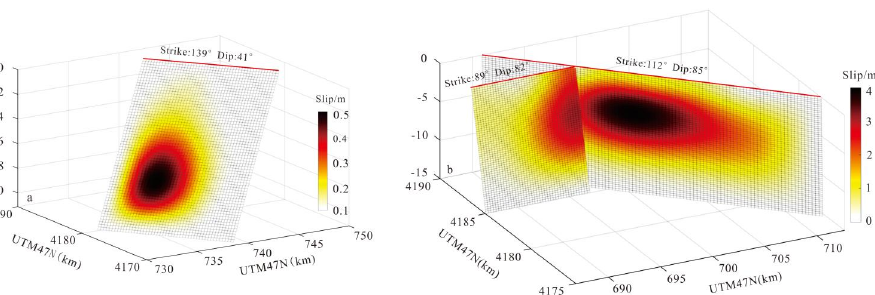
Figure 5. Distributed slip model of ( a ) the 2016 Menyuan earthquake and ( b ) the 2022 Menyuan